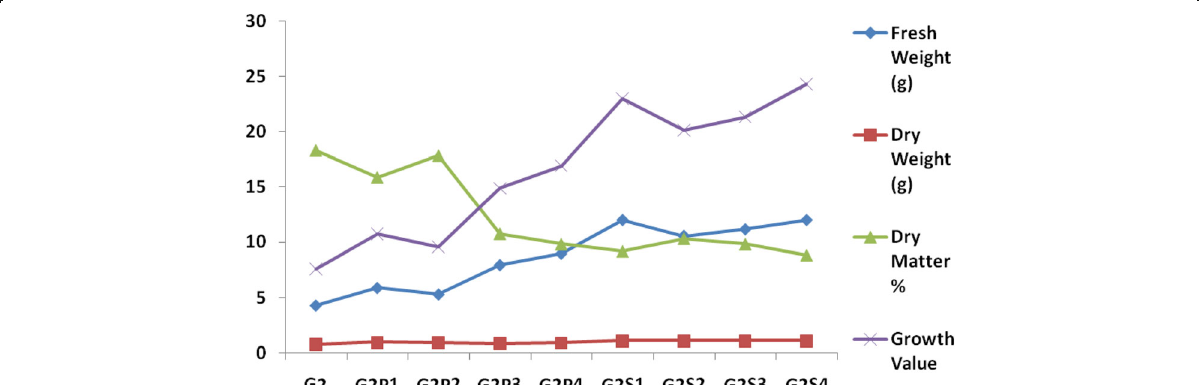
Fig. 5 Callus growth measurements in the third harvest. G2 control = 4 mg/l TDZ, G2P1 = 4 mg/l TDZ + 2 mg/l PA, G2P2 = 4 mg/l TDZ + 3 mg/l PA, G2P3 = 4 mg/l TDZ + 4 mg/l PA, G2P4 = 4 mg/l TDZ + 5 mg/l PA, G2S1 = 4 mg/l TDZ + 34.5 mg/l SA, G2S2 = 4 mg/l TDZ + 69 mg/l SA,